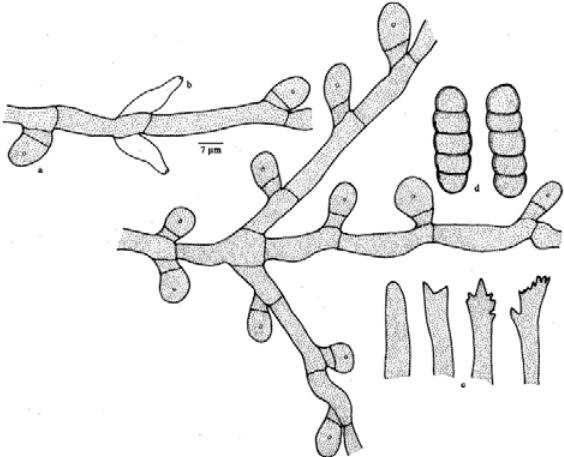
Figure 73. Meliola flemingiicola a - Appressorium; b - Phialide; c - Apical portion of mycelial setae; d -